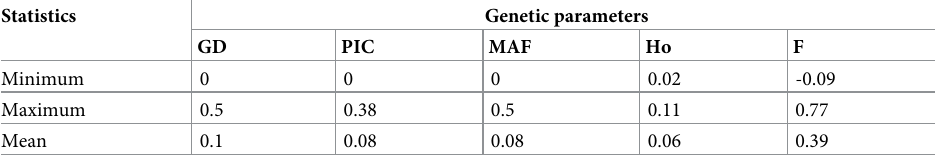
Table 5. Diversity indices statistics of the 99 groundnut genotypes based on 16 363 SNP